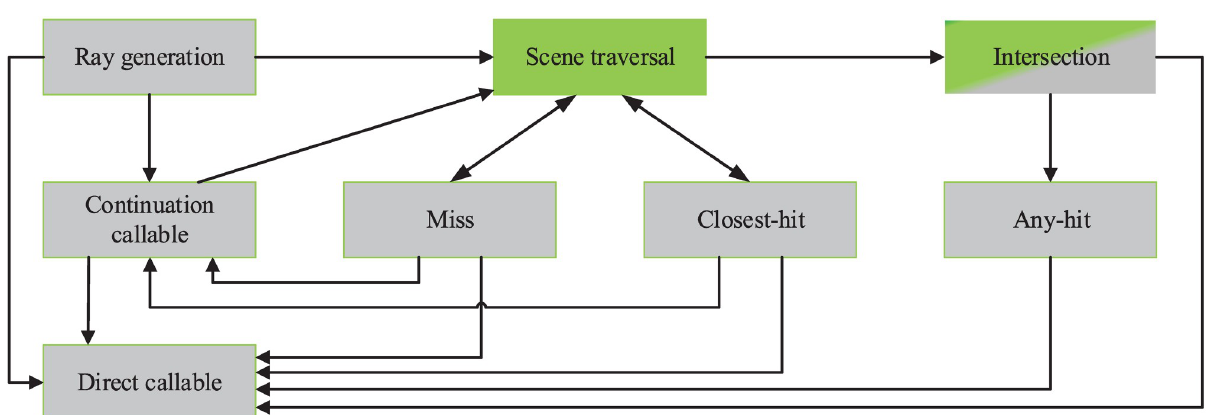
Fig 2. Relationship of OptiX programs. The green boxes represent fixed algorithms provided by the OptiX; the gray boxes represent user-specified programs.